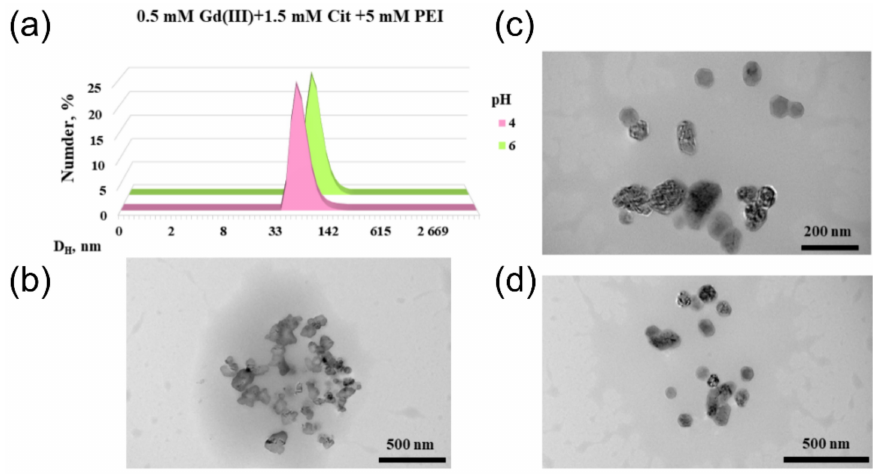
Figure 7. Size distribution characterized by DLS ( a ) and TEM images ( b – d ) of Gd(III)–Cit–PEI0 system for pH 4 ( b ), pH 6 ( c , d